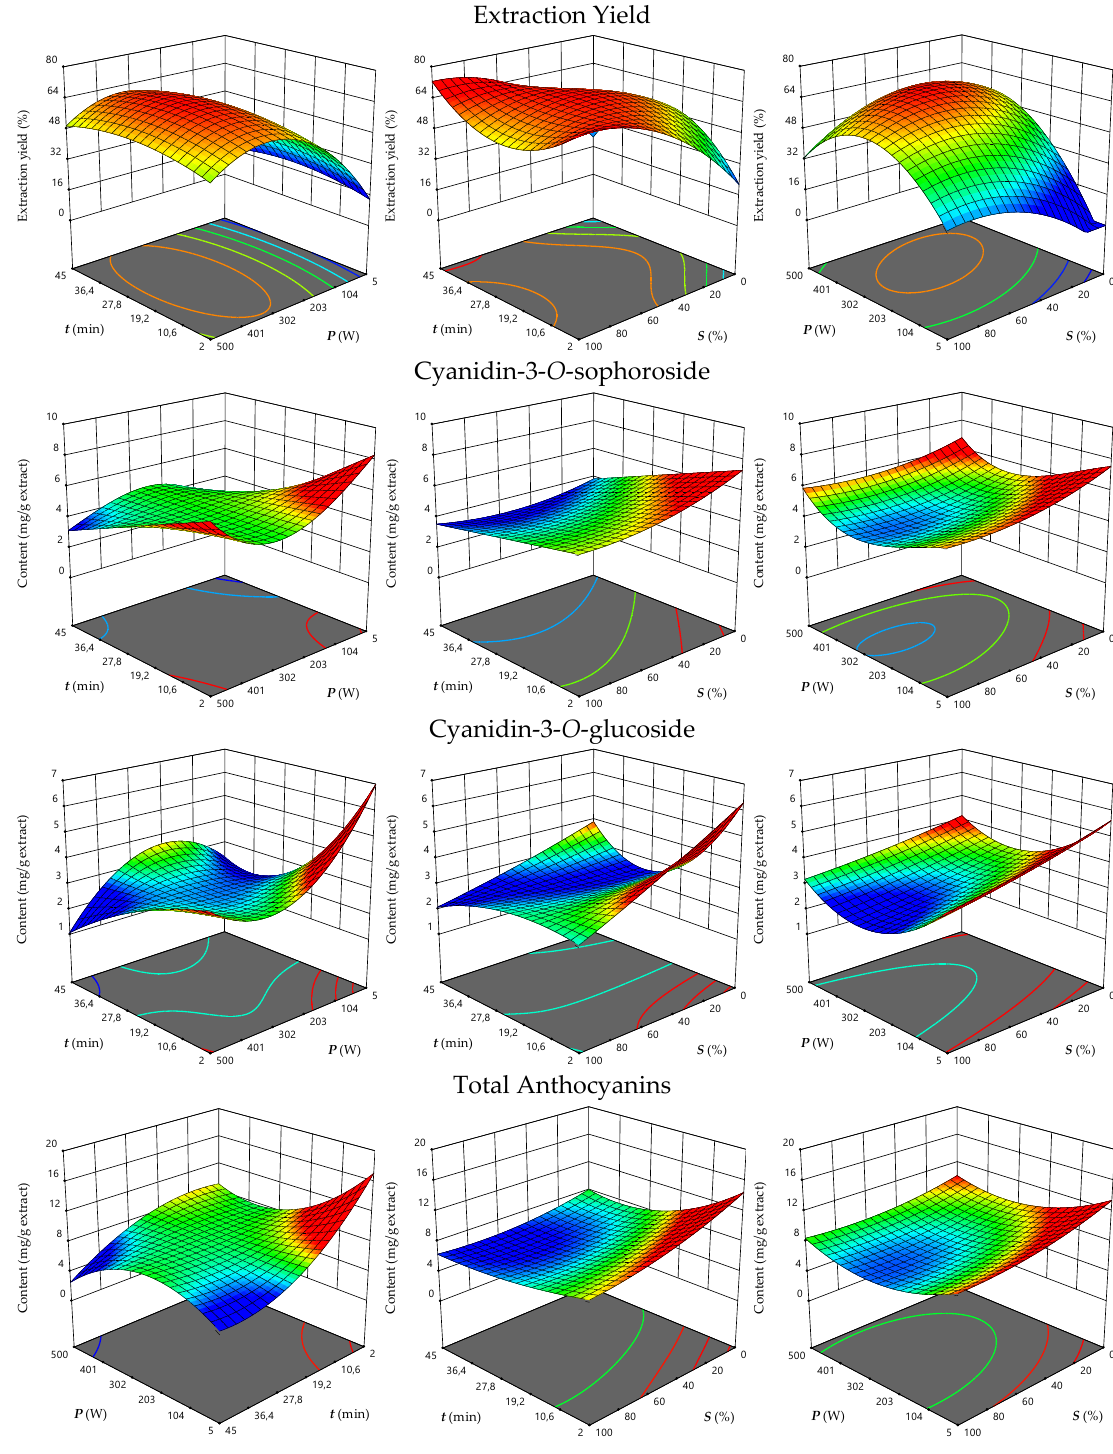
Figure 2. Response surface graphs for the effects of extraction time ( t ), ultrasonic power ( P ), and ethanol concentration ( S ) on the extraction yield (%) and levels of cyanidin-3- O -sophoroside (C3S), cyanidin-3- O -glucoside (C3G), and total anthocyanins (mg/g extract) obtained from red raspberry by the UAE process. In each graph, the excluded variable was positioned at its optimal value (Table 3).